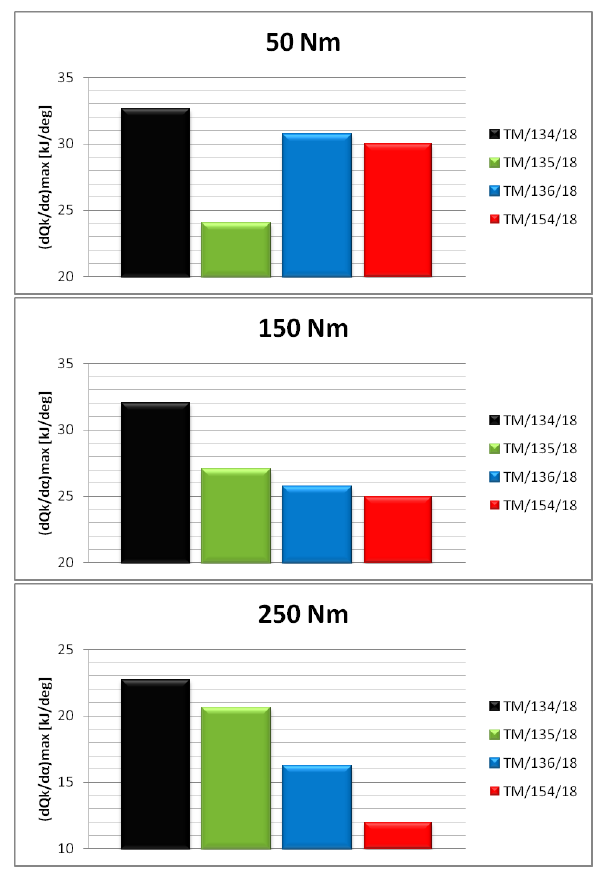
Fig. 6. Maximum heat release speed (dQ k /d  ) max in the engine cylinder in the kinetic combustion phase at selected engine duty point for the four tested